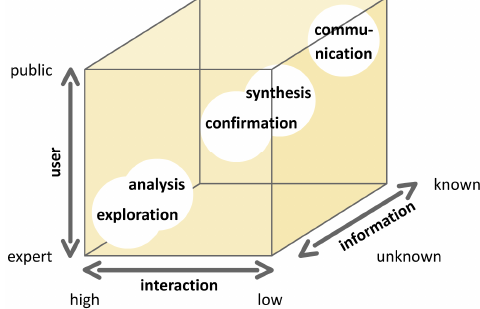
Figure 1. The purposes of geovisualization from exploration to (adapted from MacEachren & Kraak